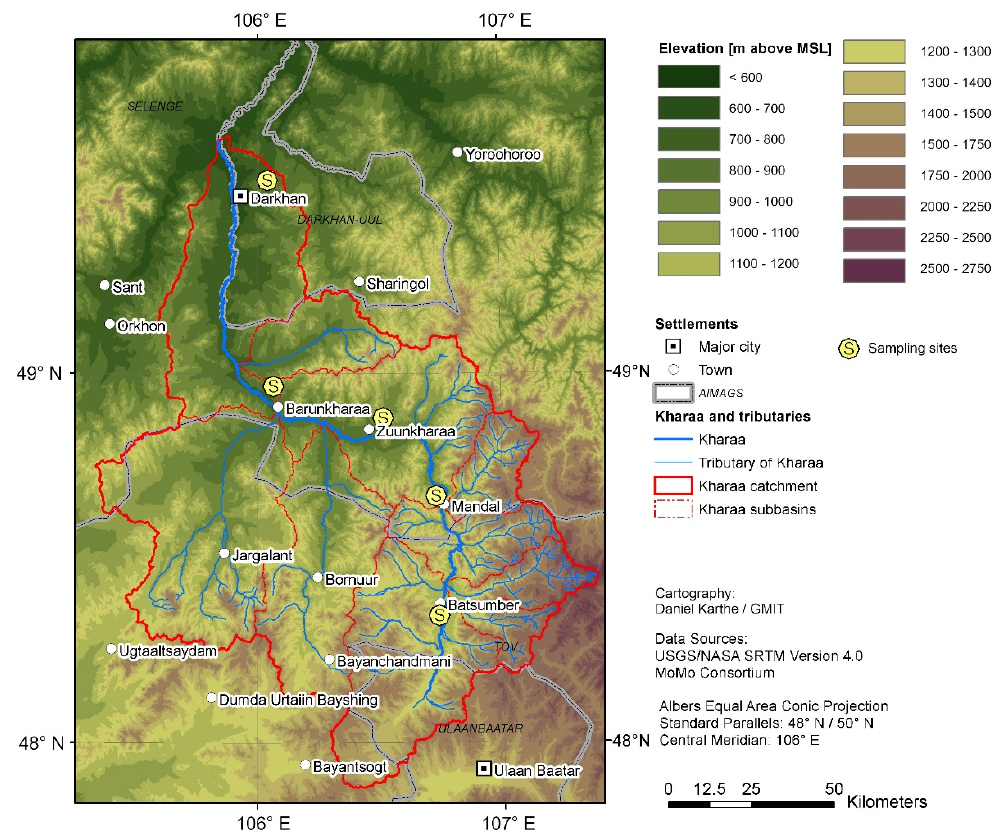
Figure 2. Location of sampling sites within the Kharaa River Basin (KRB) .